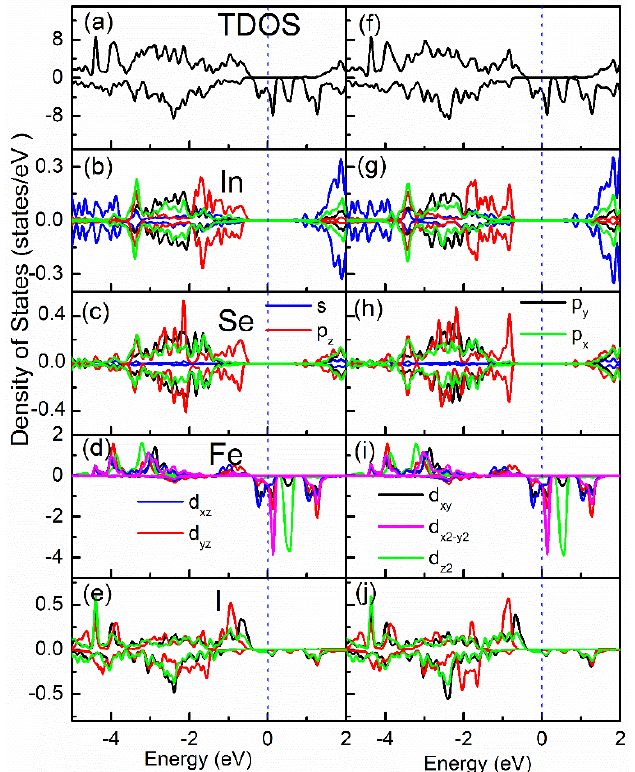
Figure 4. The density of states (DOS) spectra for C-1 ( a – e ) and C-3 ( f – j ) configurations. The ( a ) and ( f ) are the total DOS. In ( b – e ) and ( g – j ), different orbitals are presented by different colors provided in the figure. The vertical dashed blue lines indicate the positions of the E F.